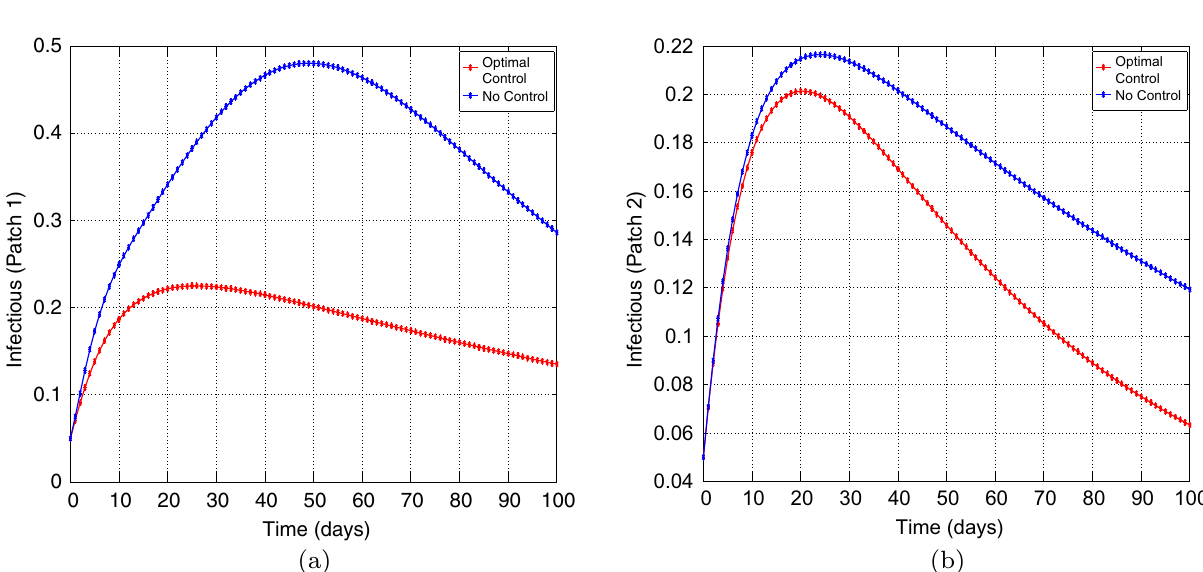
Figure 7. Simulation outcomes for the presented two patch COVID-19 mathematical model for case 2 under symmetric weak coupling ( a ) the number of infected humans in patch 1 ( b ) the number of infected humans in patch 2. In both figures, the red curves and blue curves are for the infected population, with optimal control and no optimal control